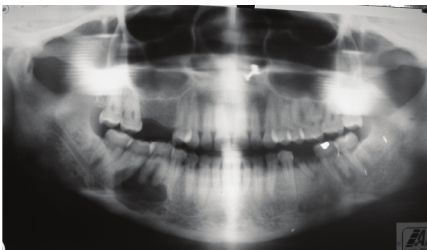
Figure 2: Orthopantomograph reveals a well-localized unilocular radiolucency in the mandibular first molar area on the right side involving the second premolar and second molar roots. Resorption of alveolar bone and loss of lamina dura around the first molar roots is also present.